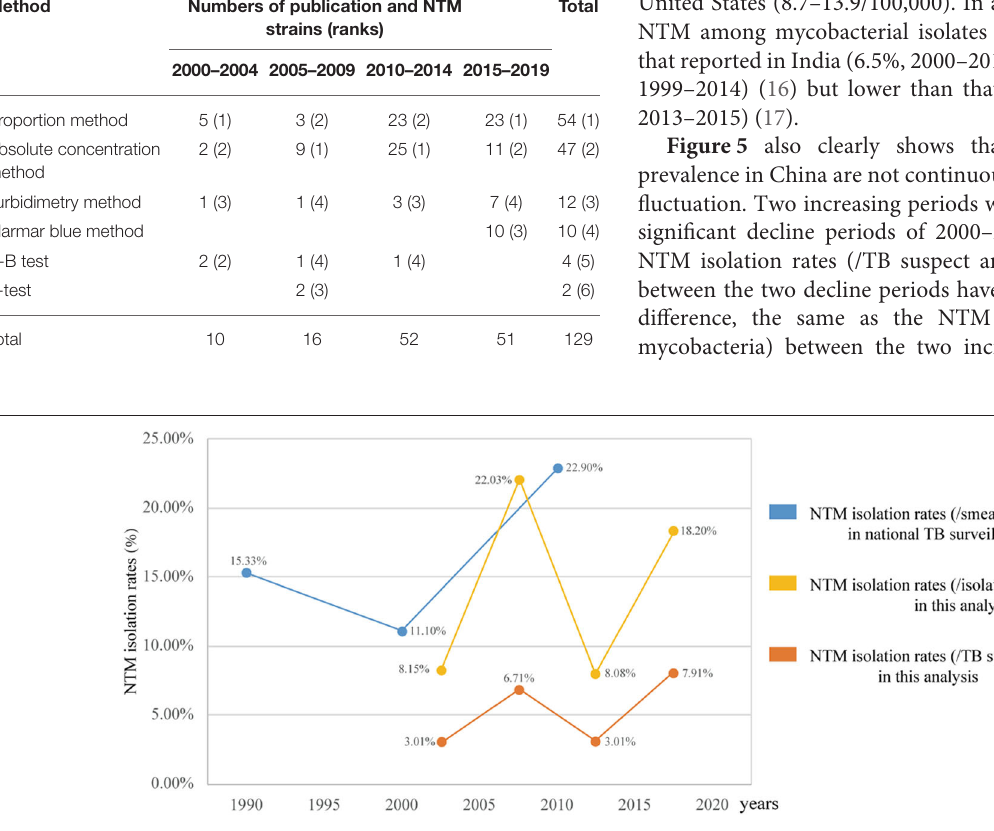
FIGURE 4 | Antibiotic resistance rates of the top 10 clinical non-tuberculous mycobacteria species. The red lines indicate the average rates, while the black dots indicate the actual resistance rates reported in the papers. Inh, isoniazid; Rif, rifampicin; Emb, ethambutol; Lfx, levofloxacin; Mxf, moxifloxacin; Lzd, linezolid; Cfz, clofazimine; Cs, cycloserine; Imp, imipenem; Mpm, meropenem; Am, amikacin; Str, Streptomycin; Pto, protionamide; PAS, aminosalicylic acid; Cm, capreomycin; Km, kanamycin; Tbm, tobramycin; Smz, sulfamethoxazole; Pa, pasinizid; Rap, rifapentine; Rfb, rifabutin; Cfx, cefoxitin; Ofx, ofloxacin; Cip, ciprofloxacin; Gat, gatifloxacin; Azi, azithromycin; Clar, clarithromycin.